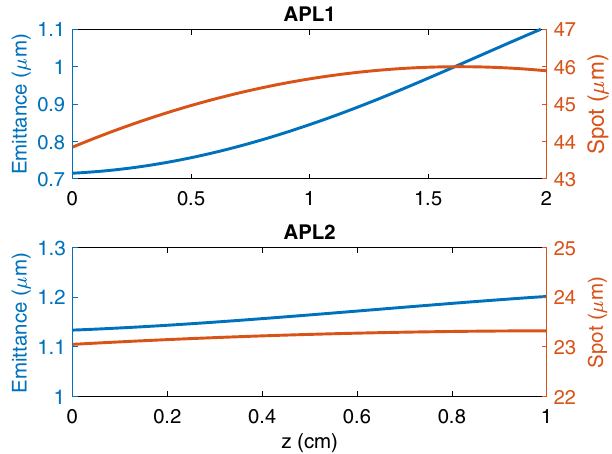
FIG. 8. Evolution of the witness normalized emittance (blue lines) and spot size (red lines) along the two